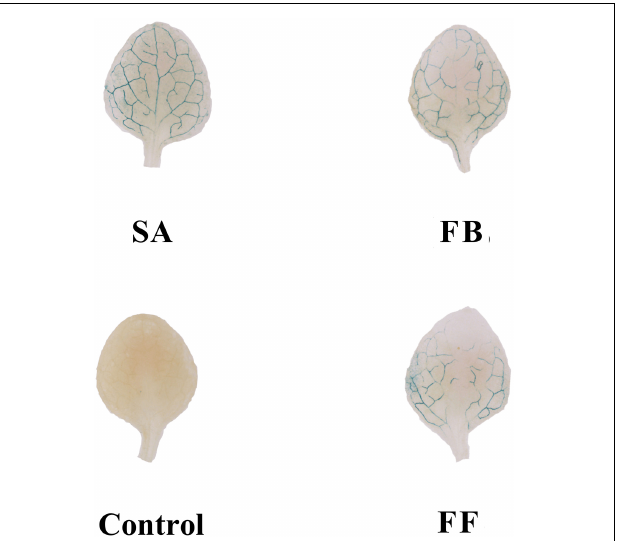
FIGURE 6 | GUS staining assay of Arabidopsis transgenic (PR1:GUS) seedlings treated with the fermentation broth (FB) and fermentation filtrate (FF) of Streptomyces sp. JCK-6131. SA = salicylic acid (0.1 mM), 1% GSS medium was used as a negative